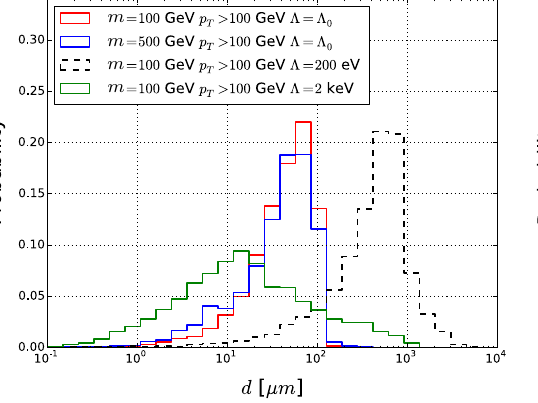
quirk pair plane thickness for different quirk charges, where we choose m = 100 GeV, p T > 100 GeV, (cid:2) = (cid:2) 0